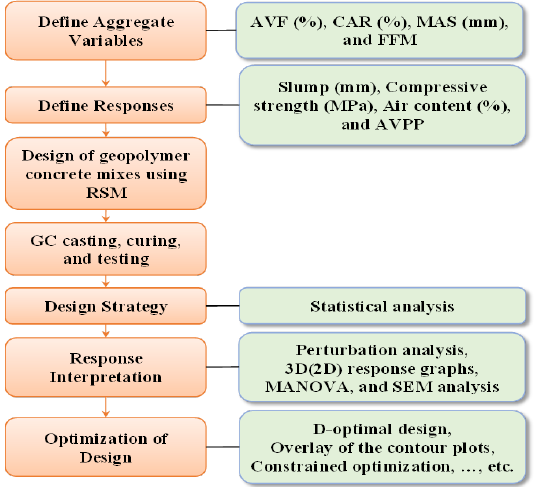
Figure 2. The flowchart of the research processes.